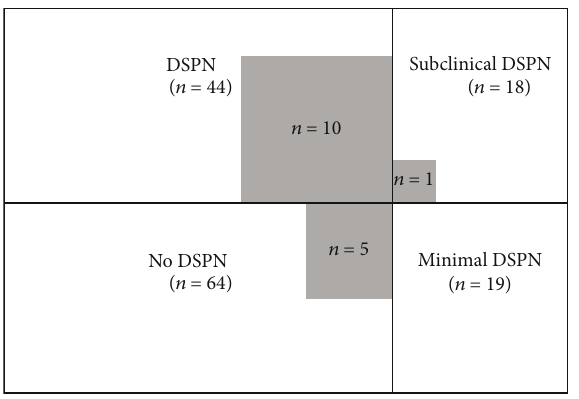
Figure 1: The distribution of type 2 DM patients with or without DSPN. DM: diabetes mellitus; DSPN: distal symmetrical polyneuropathy; DPNP: diabetic peripheral neuropathic pain; mMNSI: modi fi ed Michigan Neuropathy Screening Instrument; NCS: nerve conduction studies. No DSPN: type 2 DM with mMNSI < 2 : 5 and NCS severity score = 0 -1. Minimal DSPN: type 2 DM with mMNSI ≥ 2 : 5 and NCS severity score = 0 -1. Subclinical DSPN: type 2 DM with mMNSI < 2 : 5 and NCS severity score ≥ 2 . DSPN: type 2 DM with mMNSI ≥ 2 : 5 and NCS severity score ≥ 2 . Grey: DPNP including in each subgroup, type 2 DM with DN4 ≥ 4